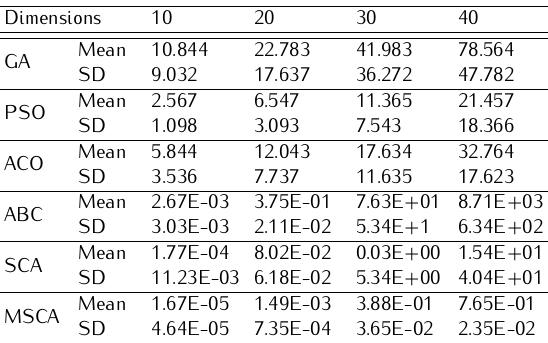
Table A.4. The results of GA, PSO, ACO, ABC, SCA and MSCA for Griewank function.